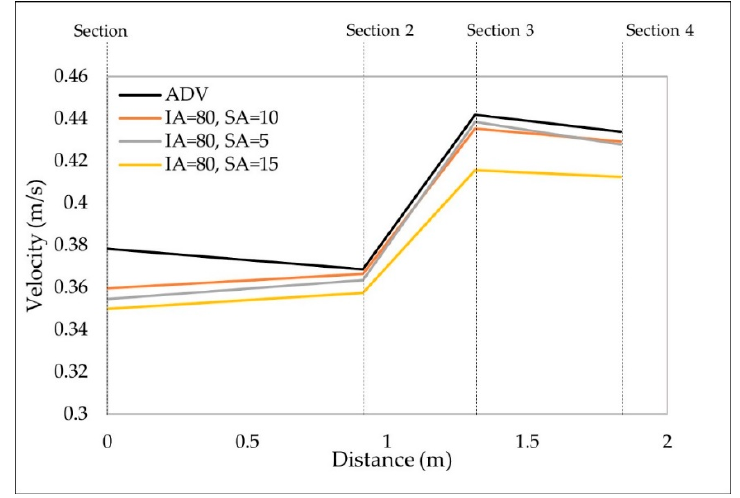
Figure 11. The sensitivity of measured velocities to SA at the centerline